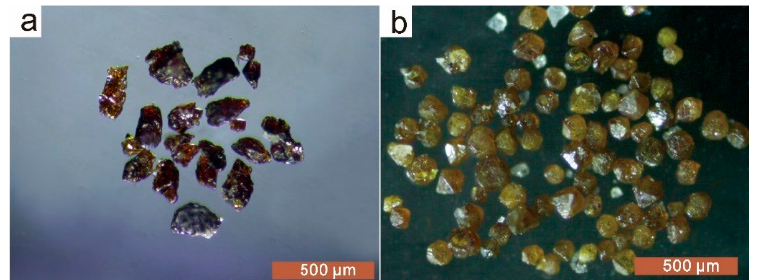
Figure 10. Photomicrographs of pyrochlore group minerals from the Baicao and Xiaoheiqing deposits. ( a ) Allotriomorphic granular particles; and ( b ) euhedral octahedral crystals.